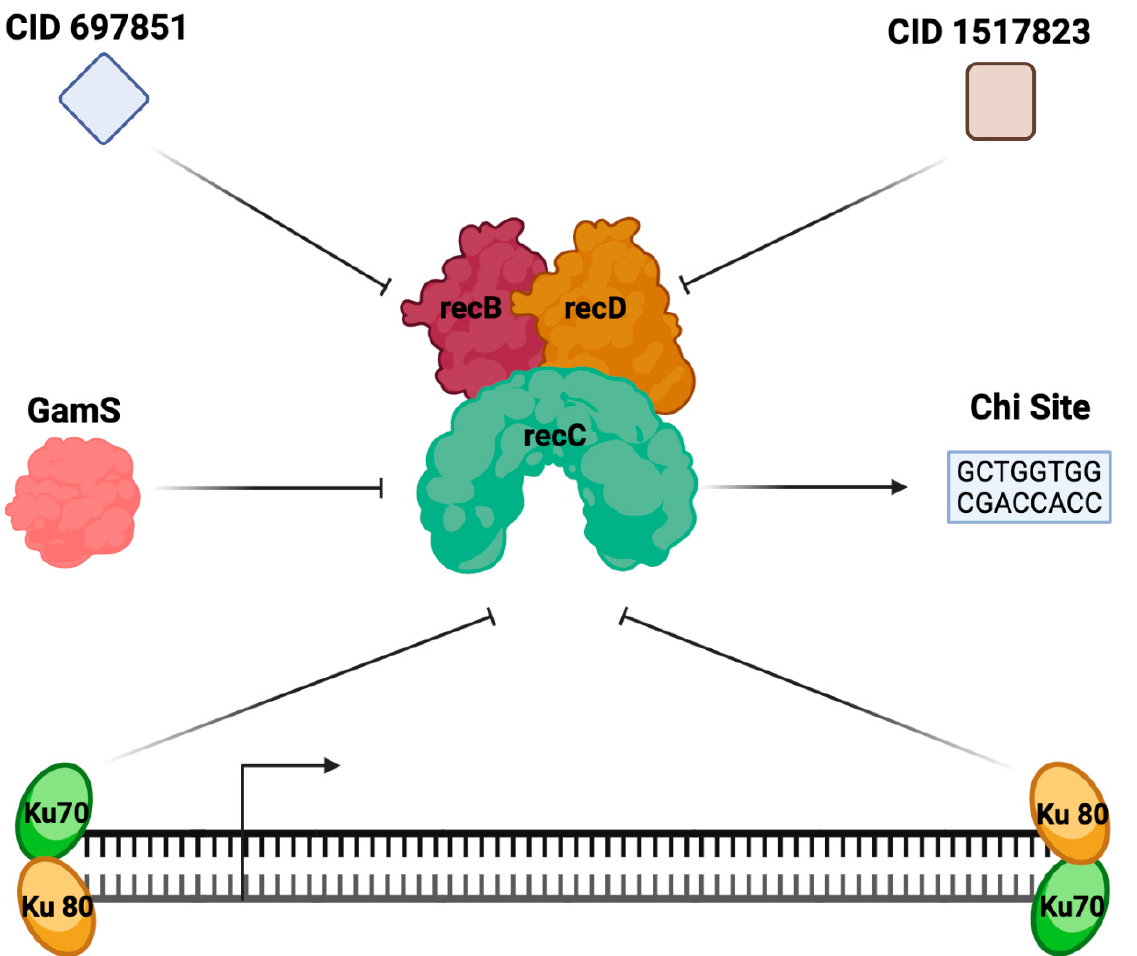
Figure 2. Competitive inhibition of Exonuclease V via GamS, Chi Sites, Ku proteins, CID69785, and CID 1517823. The mechanism of LET protection is displayed for each of the three inhibition strategies. Figure created with BioRender.com. Table 1. List of Exonuclease V inhibitors, LET expression data, and optimal concentrations and specific mechanisms for GamS, Chi, Ku, CID 697851, CID 1517823, and Tus Ter mediated protec- tion of LETs. Inhibitor